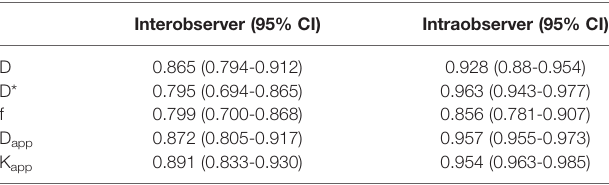
TABLE 2 | The interobserver and intraobserver reproducibility of measurements of thyroid nodules with IVIM and DKI. Interobserver (95%